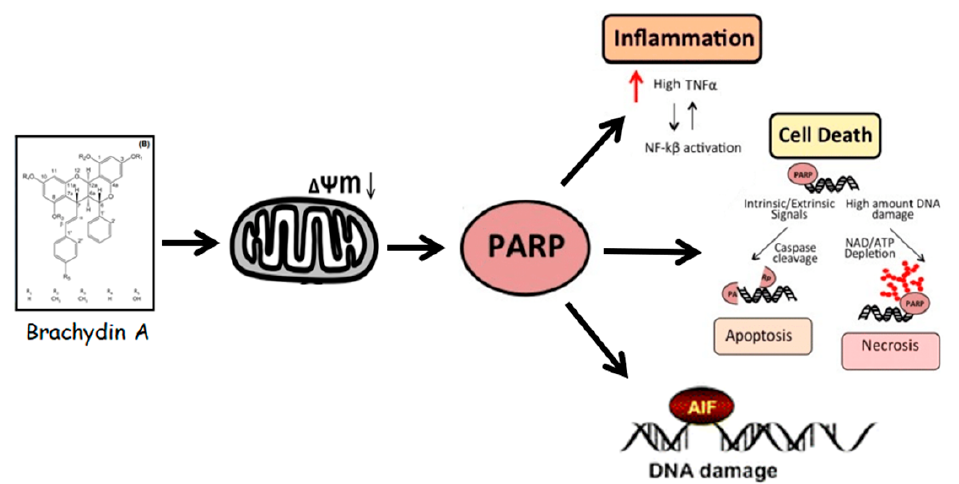
Figure 8. A proposed model of Brachydin A (BrA) effects in mPCa (DU145) tumor spheroids.